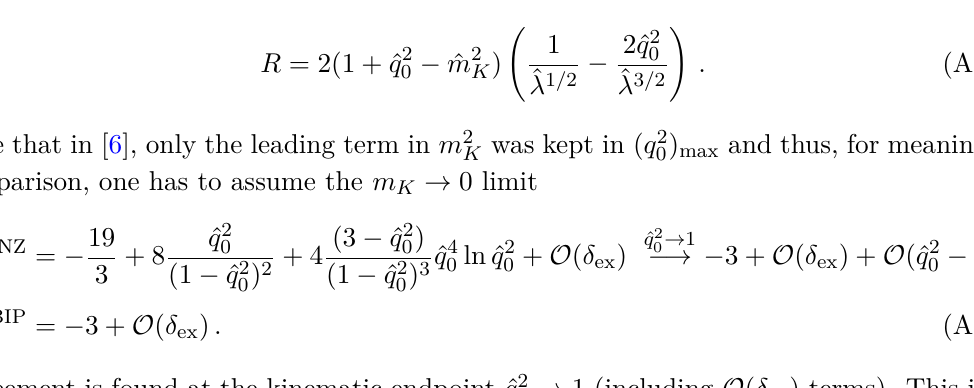
-spectrum 0 /m B ) 2 B